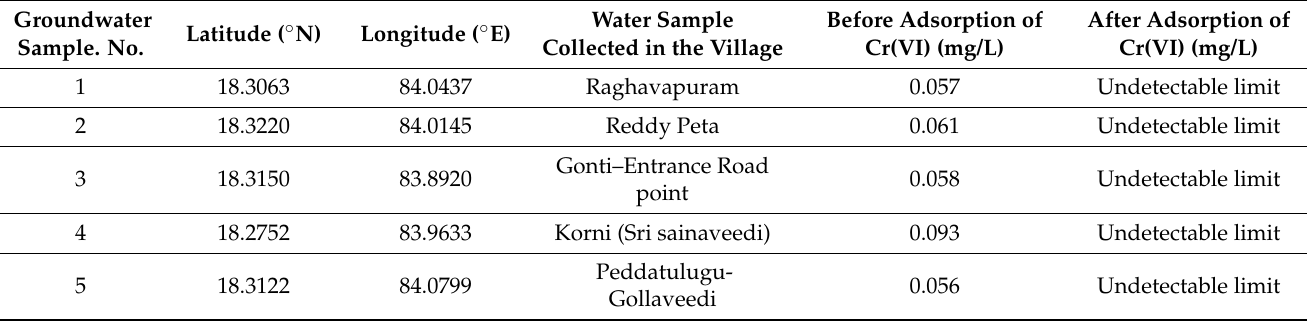
Table 5. The concentration of Cr(VI) in groundwater samples before and after adsorption using Al-GNSC